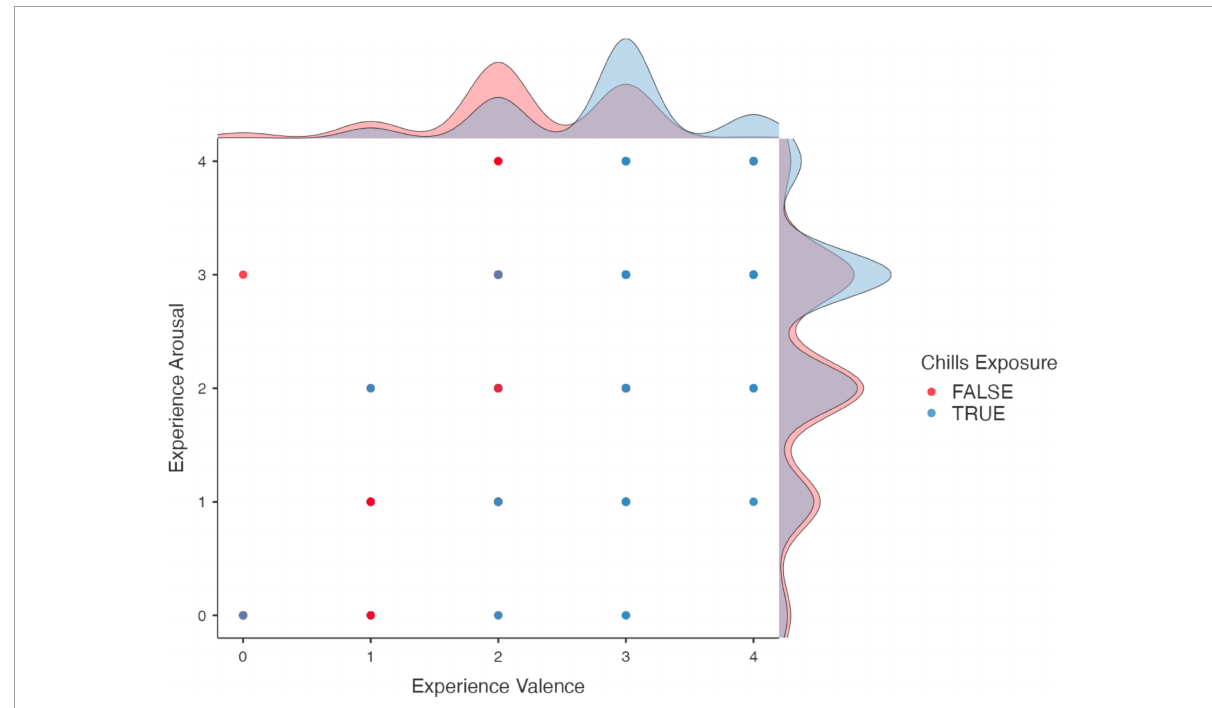
FIGURE3 Distribution of experience rating for participants depending on whether they experienced chills or not. Participants who reported chills tend to cluster toward higher arousal and valence ratings than participants who did